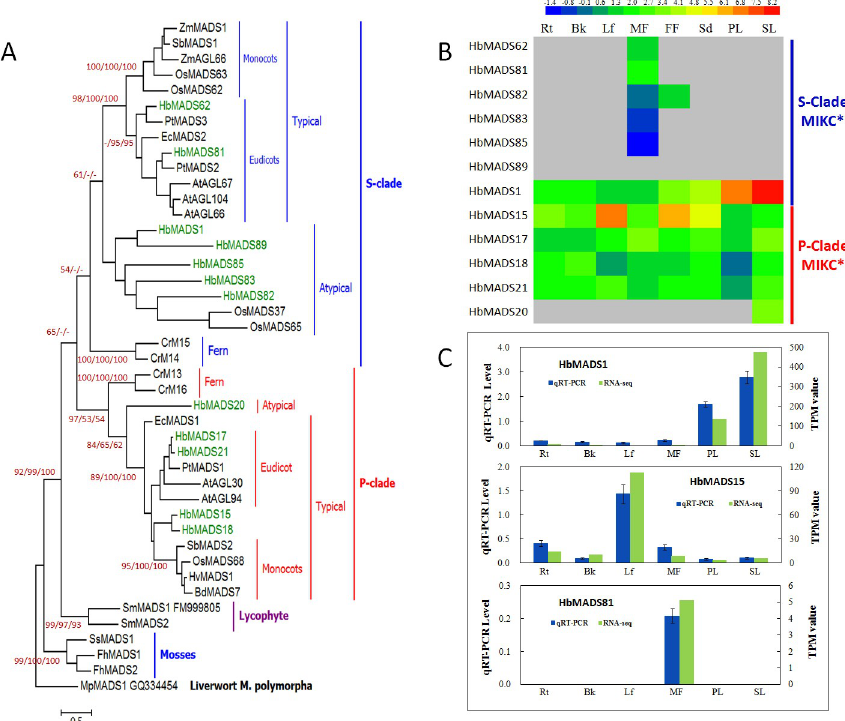
Fig 5. Phylogenetic relationships and expression profiles of MIKC � -type MADS-box proteins in the rubber tree. A, a Maximum likelihood tree. The evolutionary history was inferred using NJ, ML, and ME methods. A total of 42 MIKC � MADS-box proteins from rubber tree (prefixed with ‘Hb’), Arabidopsis (prefixed with ‘At’), rice (prefixed with ‘Os’), Zea mays (prefixed with ‘Zm’), Ceratopteris richardii (prefixed with ‘Cr’), Eschscholzia californica (prefixed with ‘Ec’), Funaria hygrometrica (prefixed with ‘Fh’), Sphagnum subsecundum (prefixed with ‘Ss’), Populus trichocarpa (prefixed with ‘Pt’), Hordeum vulgare (prefixed with ‘Hv’), Brachypodium distachyon (prefixed with ‘Bd’), and Selaginella moellendorffii (prefixed with ‘Sm’) are involved in the analysis. The accession numbers of the reference sequences are provided in S6 Table. The tree is rooted with an ancient MADS-box protein MpMADS1 (GQ334454) from a liverwort species Marchantia polymorpha . All positions with less than 80% site coverage were eliminated and a total of 390 positions were used in the final dataset. Bootstrap values of conserved clades as calculated using ML, NJ, and ME methods are provided above or below the branches. Scale bar represent 0.5 substitutions. B, MIKC � expression profile by RNA-seq. C, real-time RT-PCR results of representative genes. Rt, root; Bk, bark; Lf, leaf; MF, male flower; FF, female flower; PL, primary laticifer; SL, secondary